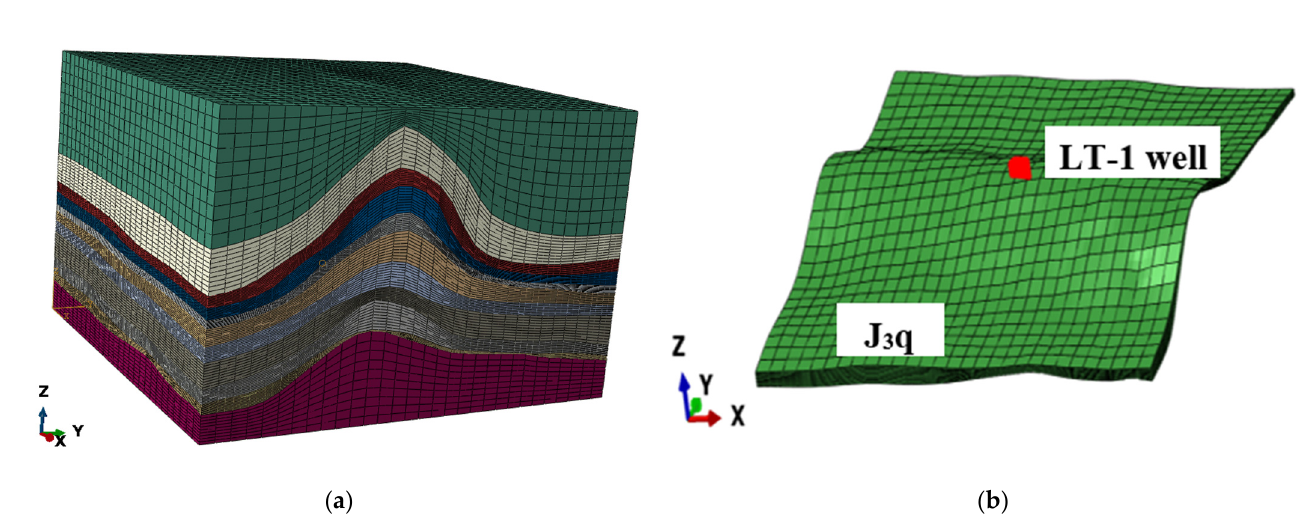
Figure 6. ABAQUS finite element model of TS block: ( a ) Model grid. ( b ) Grid of reservoir formation J3q.